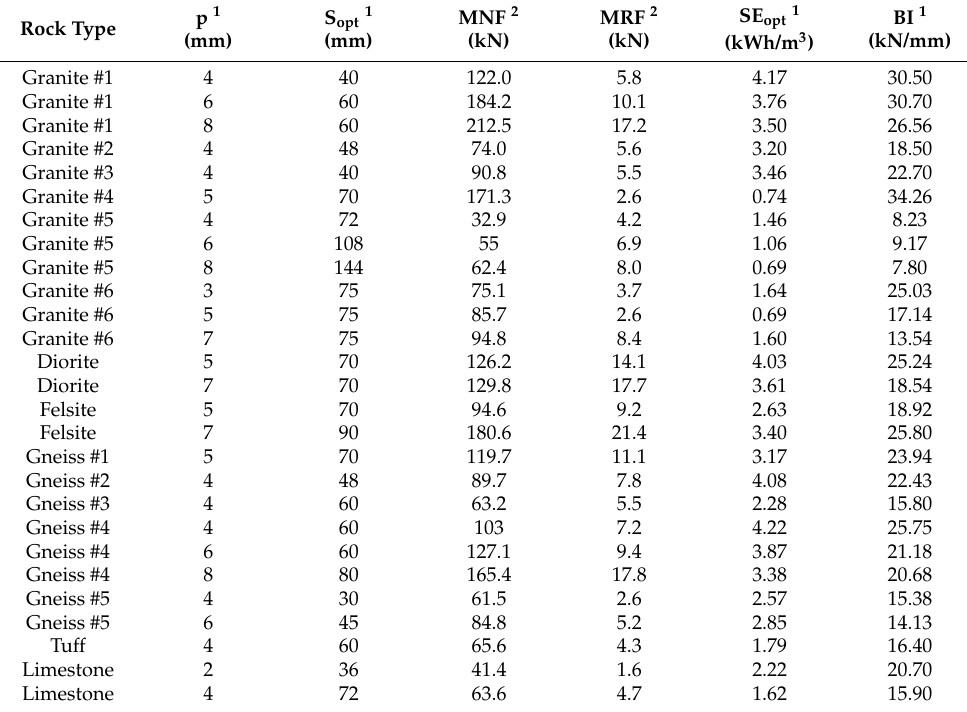
Table 3. Results of linear cutting machine test for Korean rock types (data from